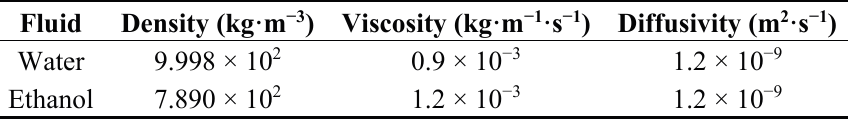
Table 1. Properties of fluids at 20 °C.